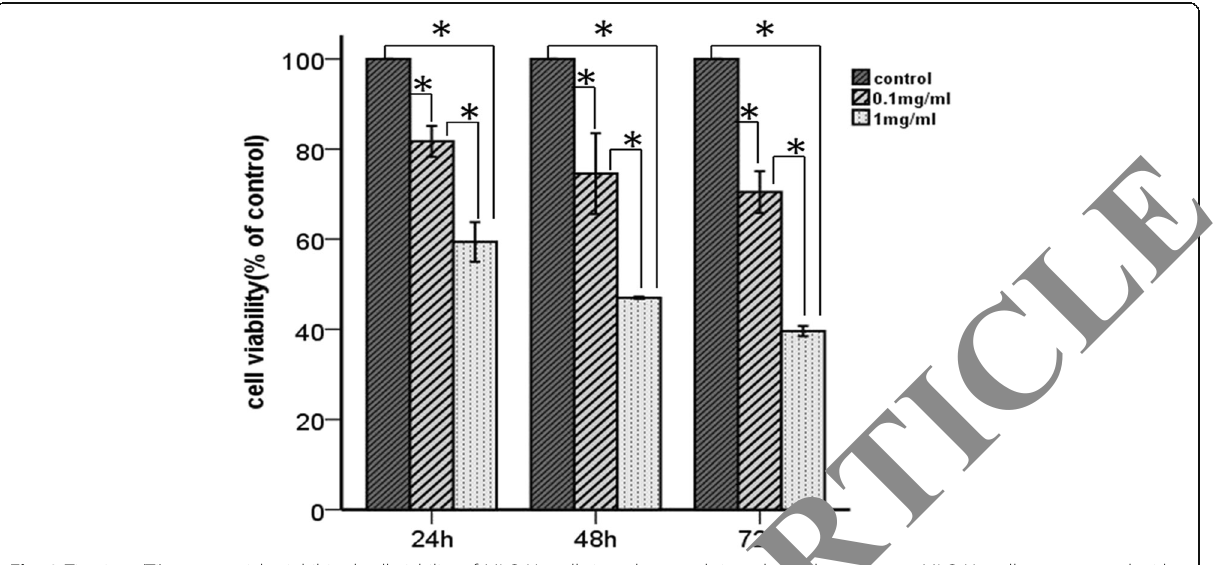
Fig. 2 Titanium (Ti) wear particles inhibited cell viability of MLO-Y4 cells in a dose- and time-dependent manner. MLO-Y4 cells were treated with various concentrations of Ti particles for 24 h, 48 h, or 72 h, and cell viability was measured by CCK-8 assay. Data are expressed as cell viability of control group (mean ± SD). The viability of cells exposed to 0.1 mg/mL Ti particles was significantly lower than that of the control, and inhibitory effects increased as the Ti particle concentration increased (* p < 0.05). Following treatment with the same concentration of particles, cell viability was lower at 72 h than at 24 h or 48